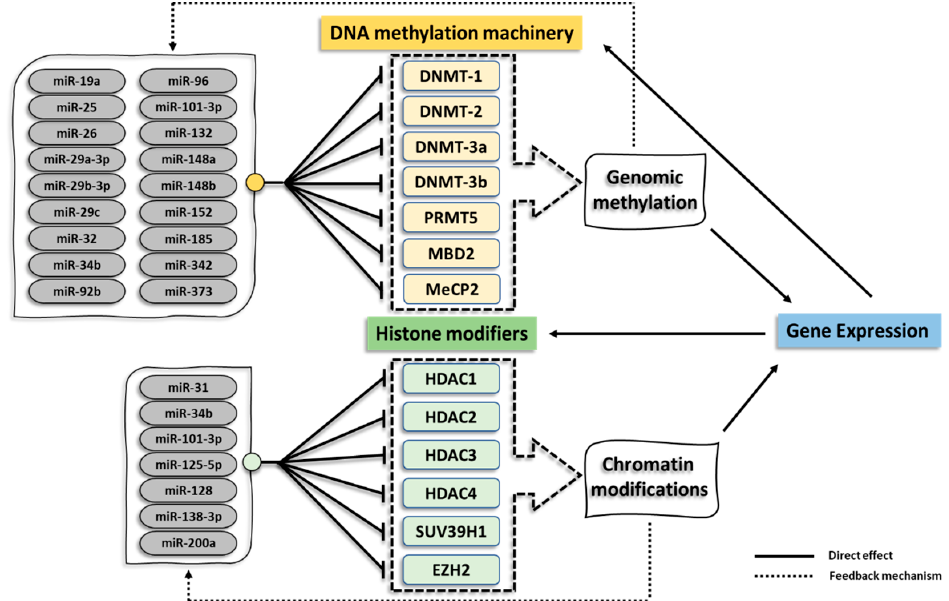
Figure 1. miRNA epigenetic crosstalk. Association of miRNAs with epigenetic regulators involved in the processes of DNA methylation and histone modification. miRNA-mediated alteration of these regulators causes aberrant DNA methylation and chromatin modification. These distorted conditions modify the expression of genes that are involved in modulating the epigenetic machinery and can also affect miRNA expression.